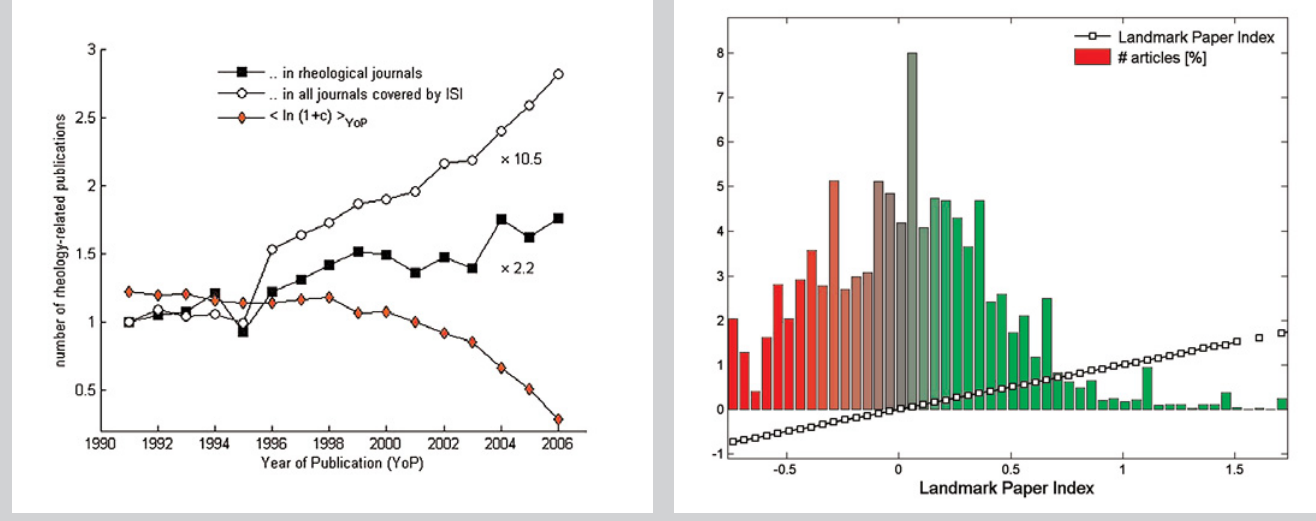
Figure 1 (left): Number of rheology-related publications versus year. Also shown here: the denominator required for the calculation of the LPI as described in the text part. Figure 2: Number of all articles – pub- lished by h -journals in the time frame 1991 - 2007 ver- sus Landmark Paper Index (LPI). For the online edition, the bars are color-coded by the LPI